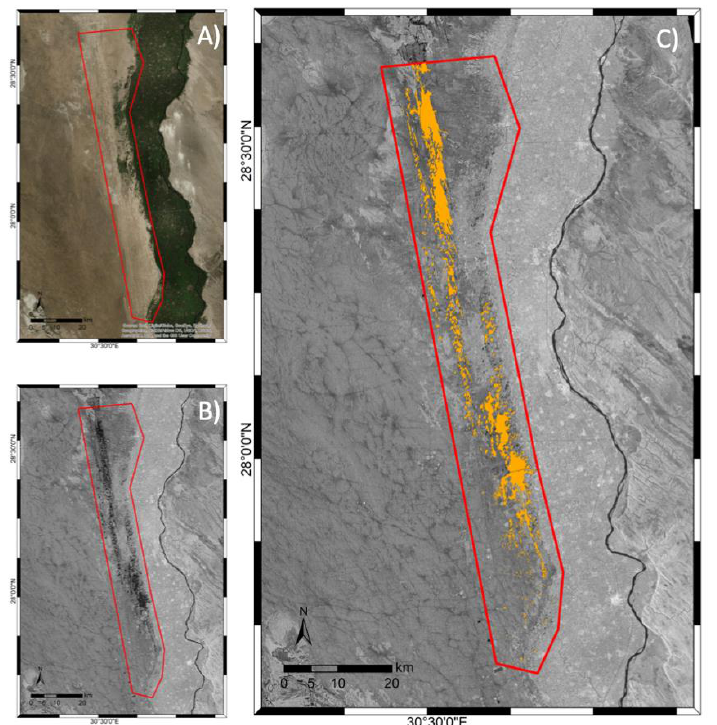
Figure 13. South Rayan Dune field view in optical ( A ), Envisat ASAR ( B ) and Envisat ASAR overlaid with the detected sand bodies ( C ). Table 5. Dune information extracted from the manually delineated dunes in Google Earth in 2007 and 2010, located in the South Rayan dune field.